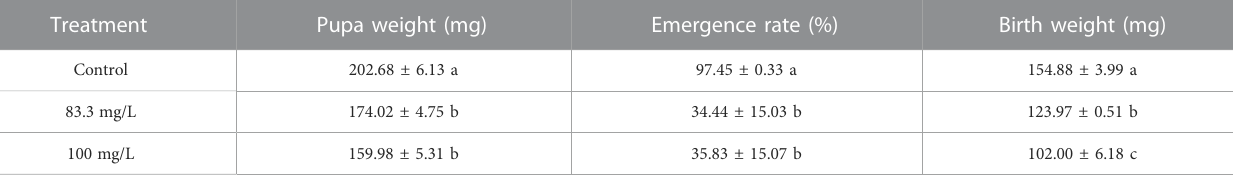
TABLE 3 Effects of pyraclostrobin on the pupa weight, emergence rate and newly emerged bee birth weight of Apis mellifera .